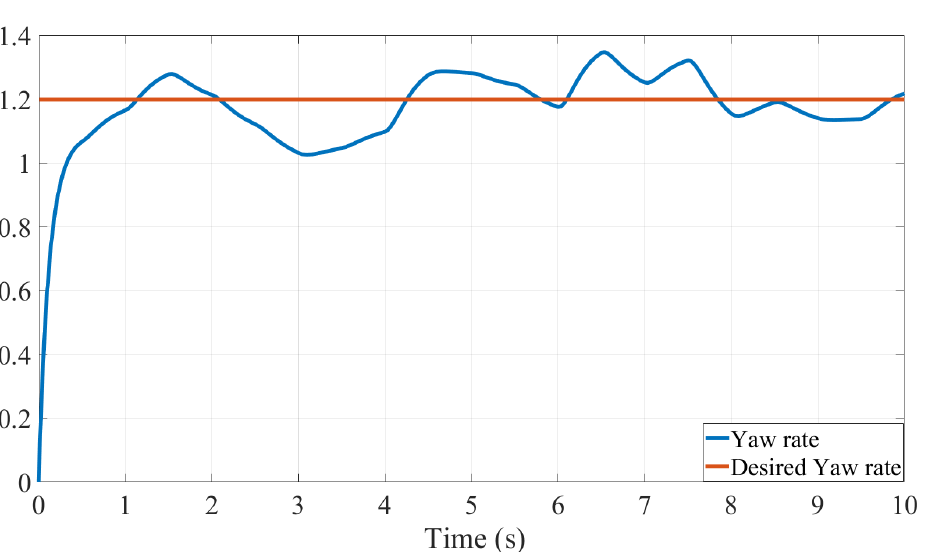
Figure 11. Uncontrolled Yaw rates with disturbance with constant